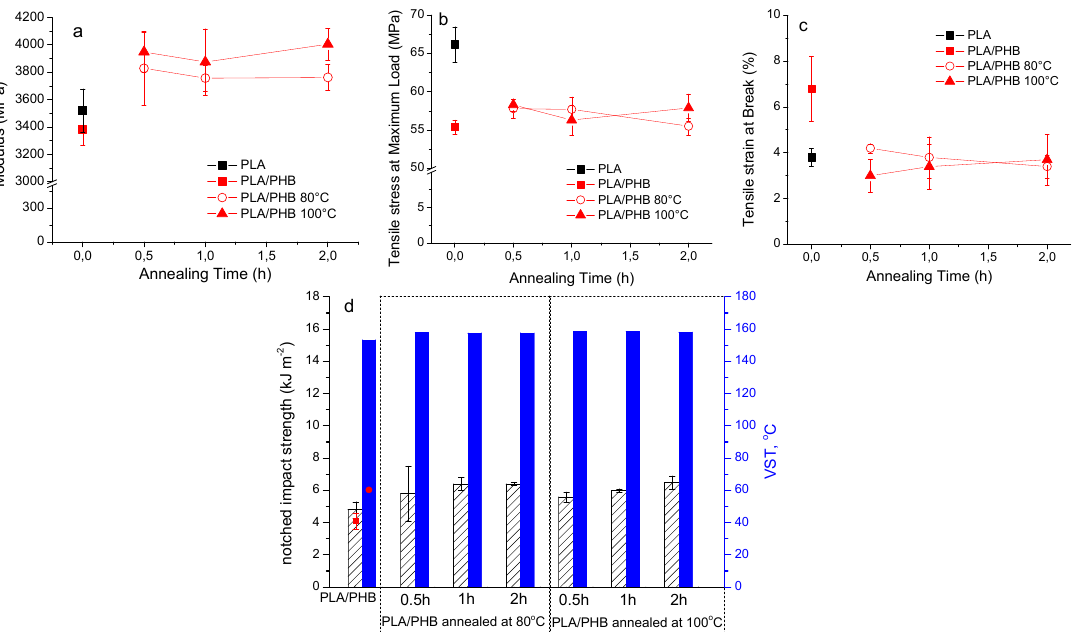
Figure 4. ( a ) Modulus, ( b ) Tensile stress at maximum load, ( c ) Tensile strain at break ( d ) Notched impact strength and VST for PLA/PHB (poly(3-hydroxybutyrate)) blends, shown with the results of neat PLA, black square in ( a – c ), red points in ( d ). Additional mechanical data are shown in Table S4 of the SI.